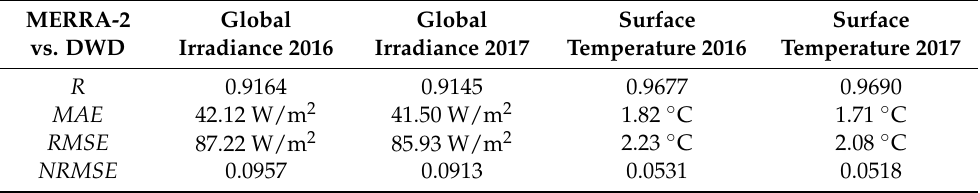
Table 9. MERRA-2 error for hourly measurements of global irradiance (GI) and surface temperature (TS) of Bremen in 2016 and 2017, in comparison with